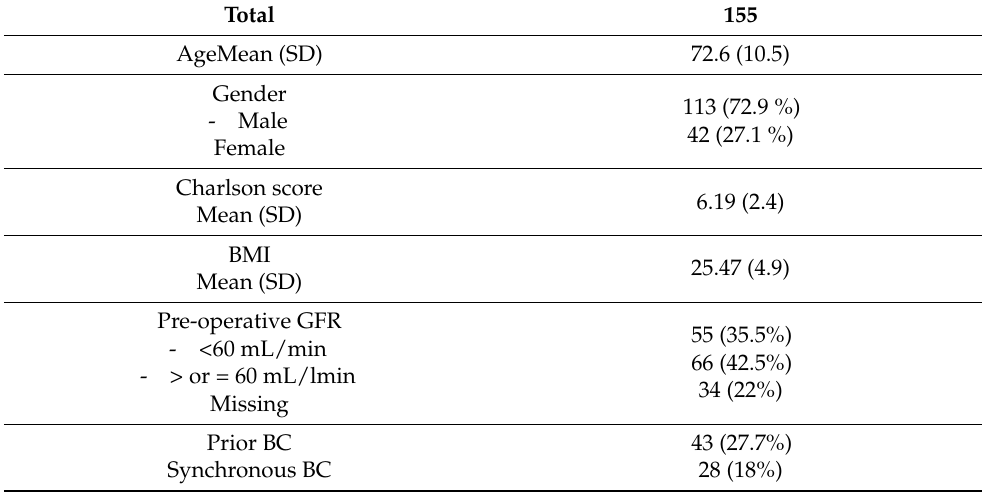
Table 1. Patients’